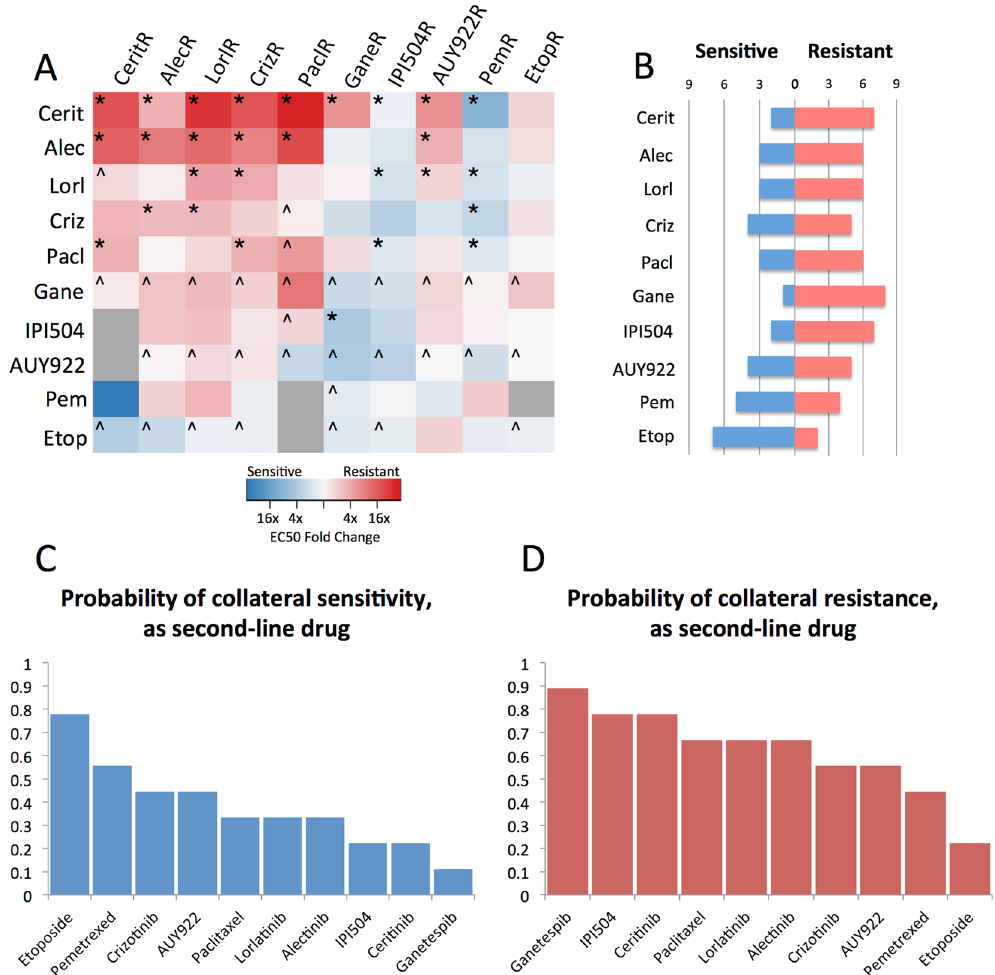
Figure 3. ( A ) Collateral sensitivity matrix of fold change of EC50 for resistant cell lines (columns) as treated by the panel of anti-cancer therapies (rows). Grey boxes are indeterminate due to significant resistance to drug. The asterisk ( * ) refers to a significant change in EC50 from treatment-naive, with non-overlapping 95% confidence intervals, and the caret (^) refers to a case in which the confidence intervals for the EC50 in one of the treated or treatment-naive cases was indeterminate. Non-significant changes are those not demarcated by either symbol. ( B ) Bar graphs depicting the number of collaterally sensitive or resistant cell lines to each drug. ( C ) Ranked probabilities of collateral sensitivity of each drug to the resistant cell lines, when the drug is used as second-line therapy. ( D ) Ranked probabilities of cross-resistance of each drug to resistant cell lines, when the drug is used as second-line